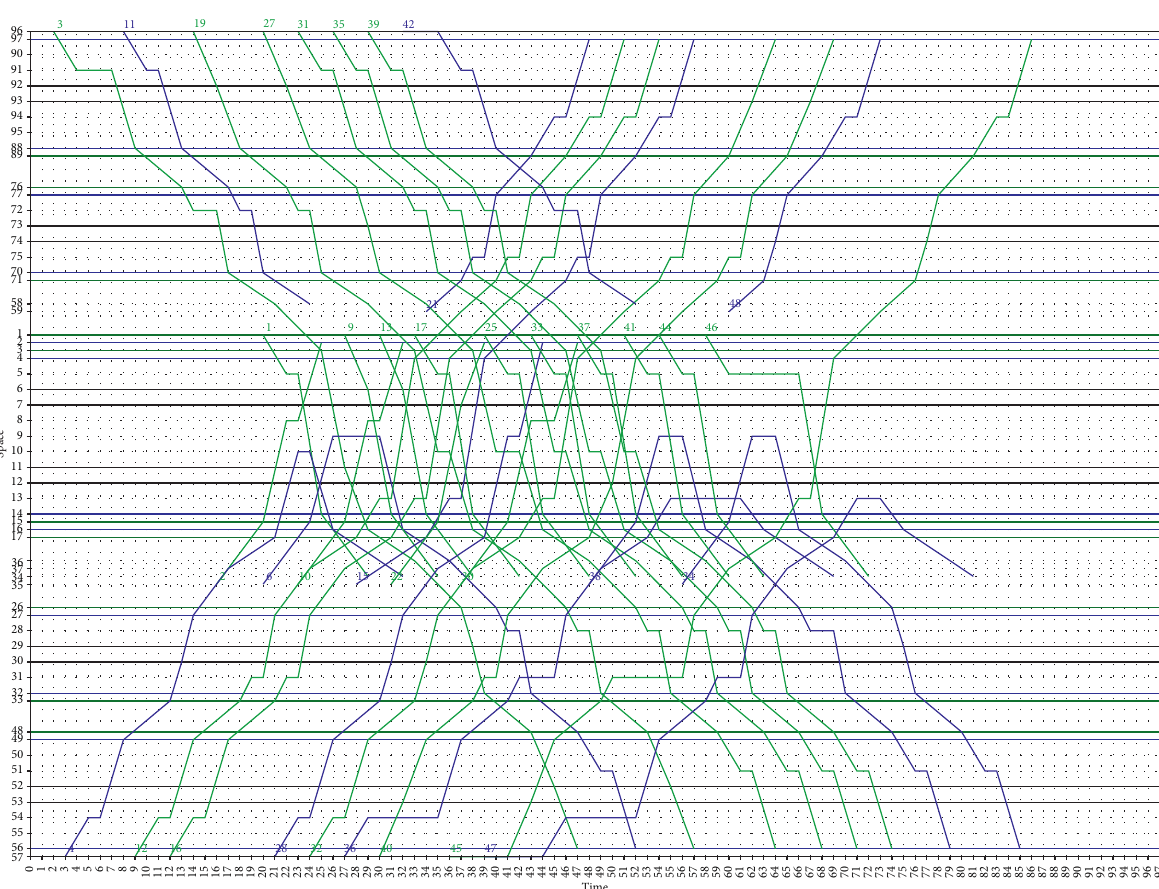
Figure 12: Train timetabling and platforming result for Line 2 for medium-sized rail